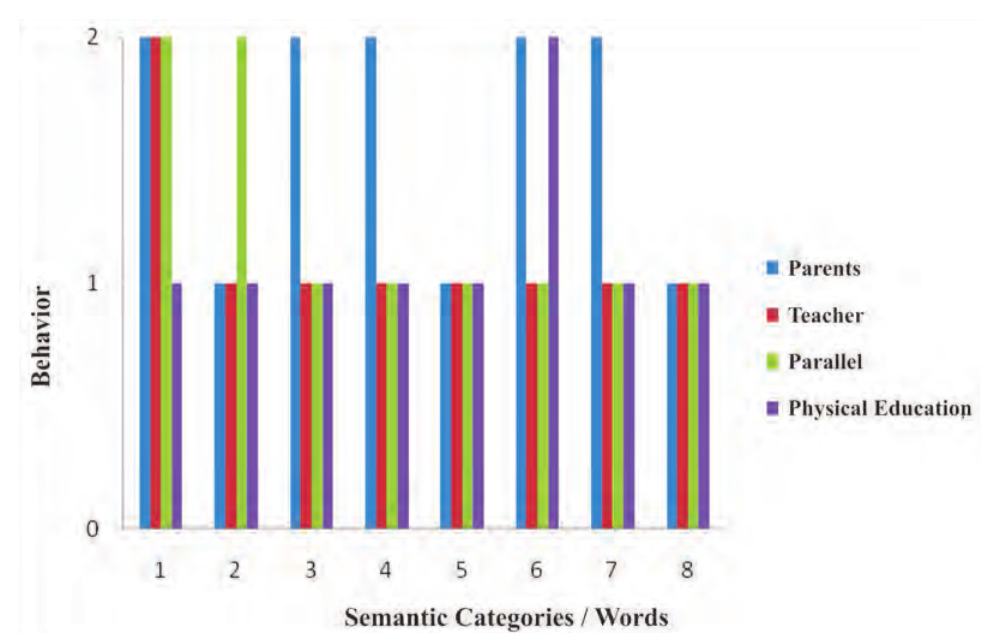
Figure 2. Semantic Categories and Use of words